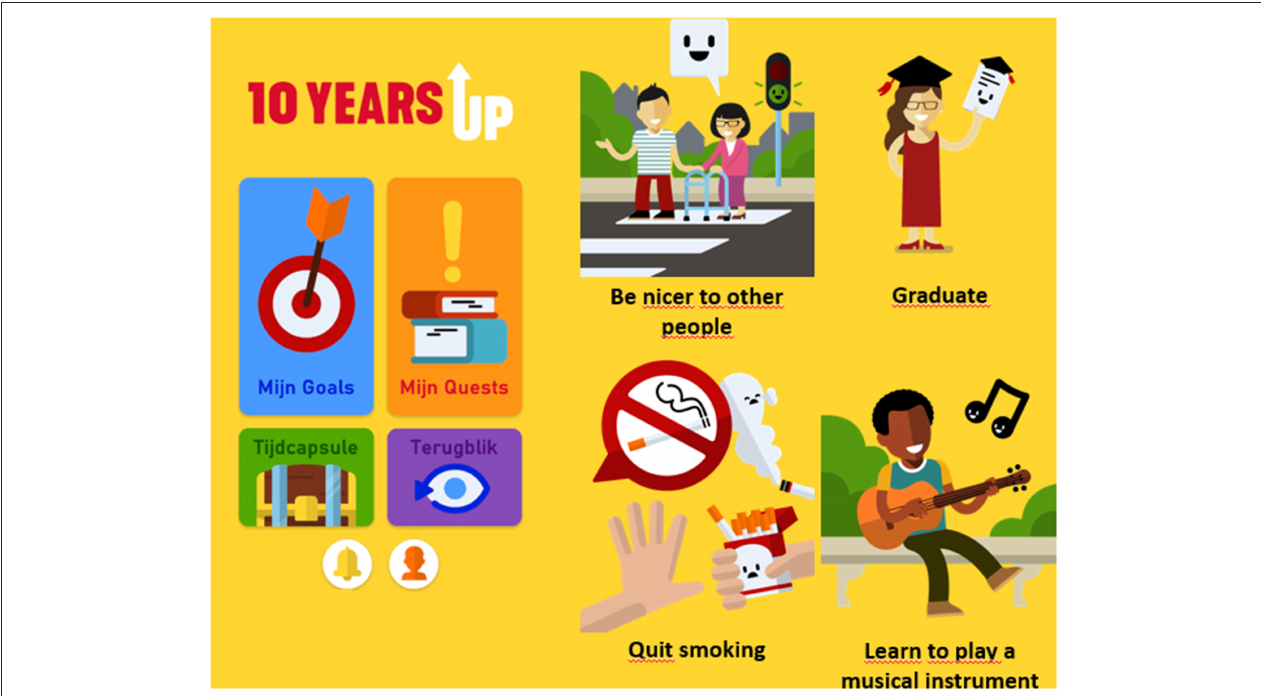
FIGURE 2 | Impression of the 10YUP app. The home screen is shown on the left hand side and includes different modules to fill in the GSSI (“My Goals”), fill in the other questionnaires (“My Quests”), and two buttons which are intended to provide incentives to participants (treasure chest). On the right hand side, four examples of goals from the GSSI are presented. Source: 10YUP app; Copyright: ©